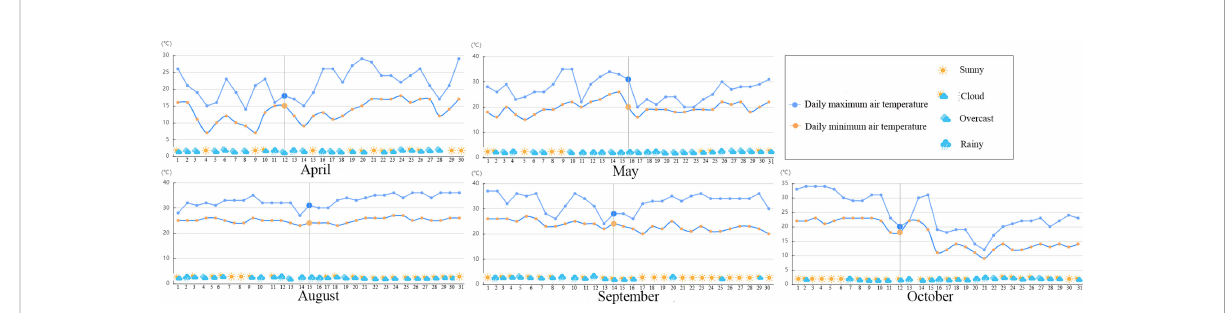
FIGURE 1 Weather conditions of mulberry cultivation base in differential